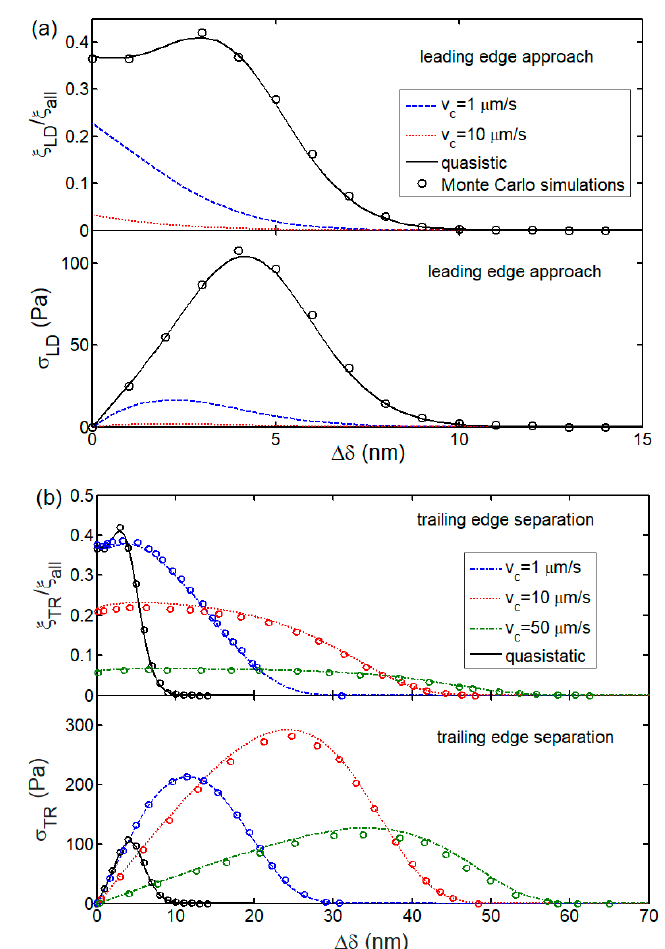
Figure 7. Normalized closed bond density and adhesion traction as a function of the change of intersurface separation ( ∆ δ = δ − l b − l bind ) for ( a ) leading edge approach and ( b ) trailing edge separation processes by taking into account the different speeds of cell rolling. Curves are theoretical results and discrete symbols stand for results from Monte Carlo simulations.